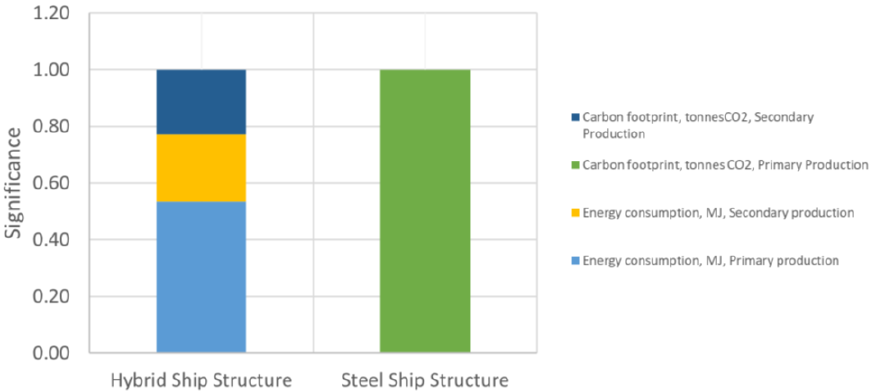
Figure 3. Significance of design criteria for energy consumption and carbon footprint.